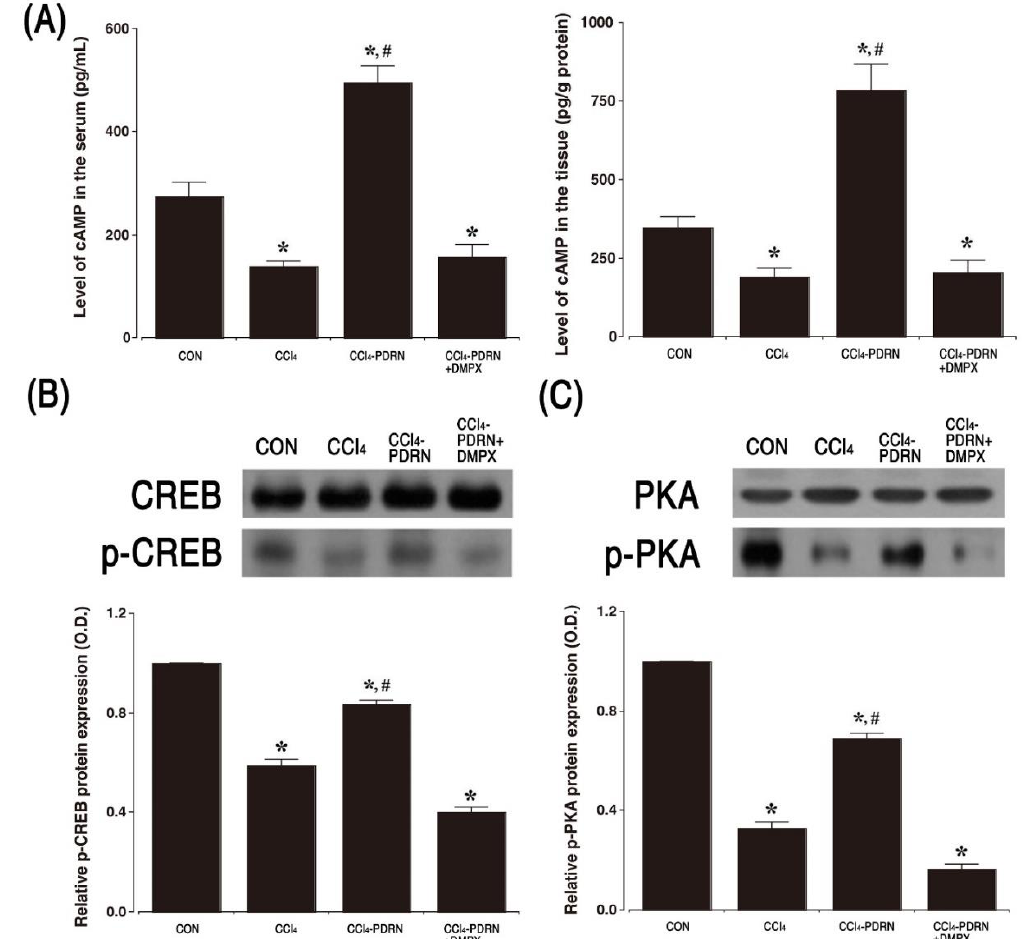
Figure 5. Expression of cyclic adenosine-3’,5’-monophosphate (cAMP), cAMP response element-binding protein (CREB) and protein kinase A (PKA). ( A ) Concentration of cAMP in serum and liver tissue. ( B ) Relative ratio of phosphorylated CREP (p-CREB) to CREB in liver tissue. ( C ) Relative ratio of phosphorylated PKA (p-PKA) to PKA in liver tissue. CON, control group; CCl 4 , CCl 4 -injection group; CCl 4 -PDRN, CCl 4 -injection and polydeoxyribonucleotide (PDRN)-treated group; CCl 4 -PDRN + DMPX, CCl 4 -injection and PDRN with 3,7-dimethyl-1-propargylxanthine (DMPX)-treated group. * indicates p < 0.05 when compared with the control group. # indicates p < 0.05 when compared with the CCl 4 -injection group.